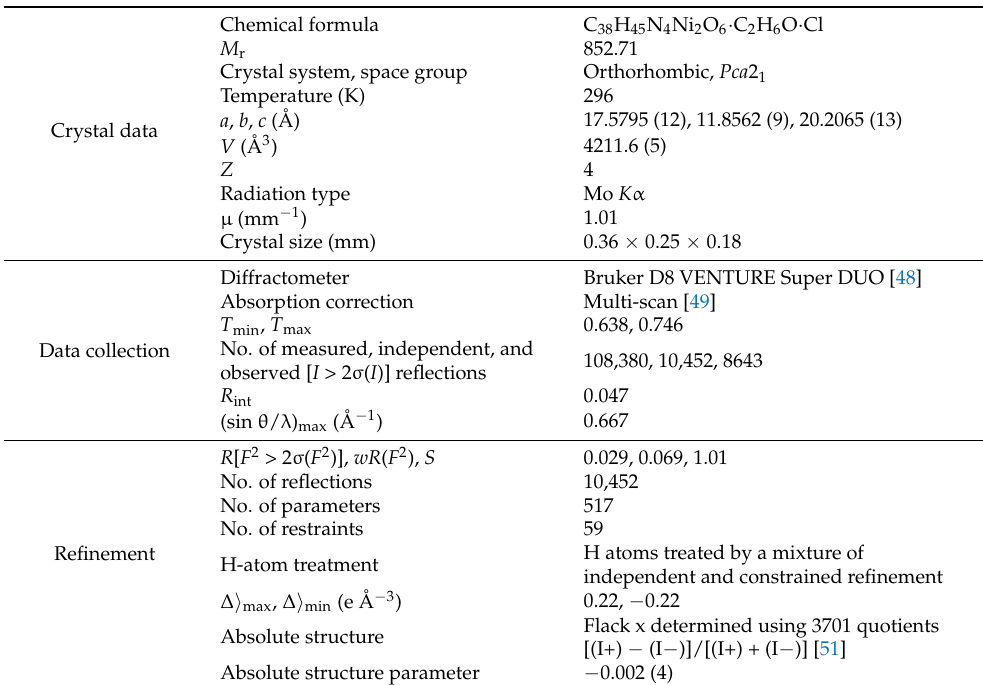
Table 3. Crystal data, data collection, and structure refinement details for the [Ni 2 HL 2 (EtOH) 2 ](Cl)(EtOH) complex.